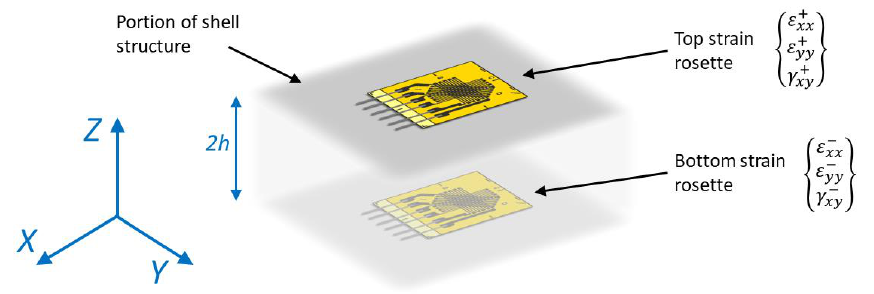
Figure 1. Discrete sensor location both on the top and on the bottom surface of the shell structure.